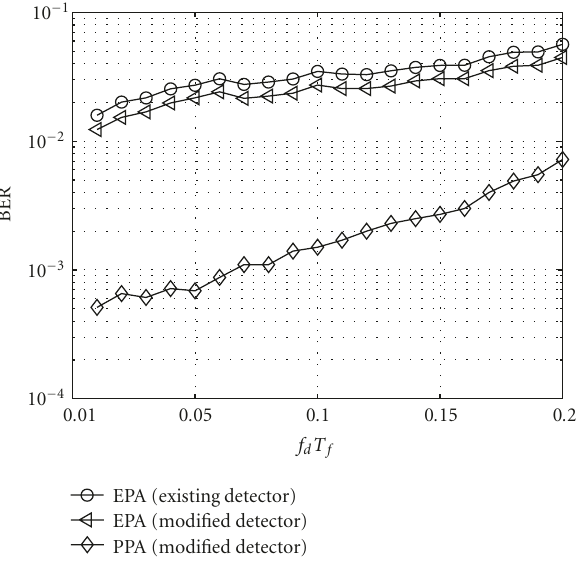
Figure 9: BER performance of di ff erent power allocation schemes under time-varying channels (QPSK, SNR = 10dB, M R = 4, M T =